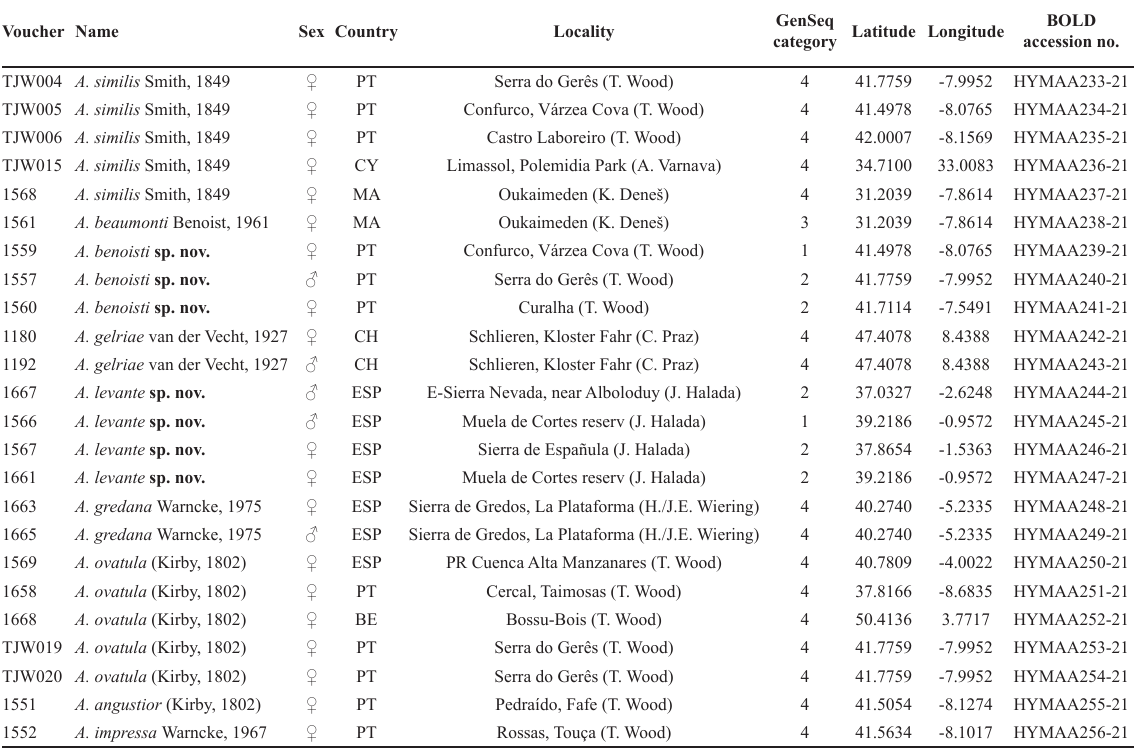
Table 1. Locality data (including co-ordinates) and BOLD accession numbers and GenSeq category (after Chakrabarty et al. 2013) for sequences produced in this study. 1 = holotype; 2 = paratype; 3 = topotype; 4 = vouchered